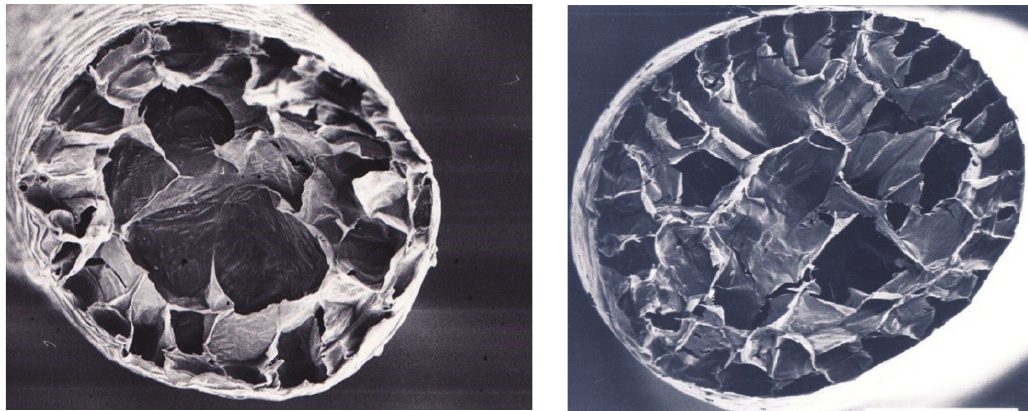
Figure 6. SEM images at a cross section of a guard hair of reindeer (left) and a musk deer (right) hair. Scale: 100 μm for both. The guard hair of musk deer is substantially thicker than the hair of the reindeer. See also Table